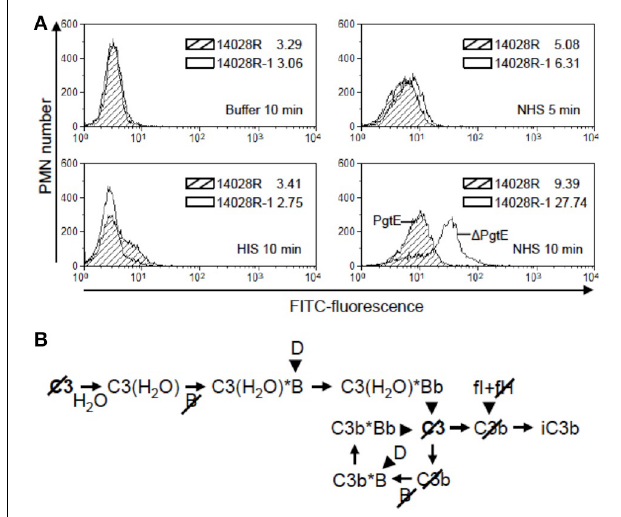
FIGURE 6 | The effect of PgtE on opsonophagocytosis of S. enterica . (A) FITC-stained S. enterica 14028R and 14028R-1 ( (cid:2) pgtE derivative of 14028R) were incubated for 5min in 50% NHS, 50% HIS or buffer. Freshly isolated human neutrophils were mixed with the bacteria at a MOI 20, and phagocytosis was allowed to take place for 5min (in NHS) or 10min (in NHS, HIS or buffer). The FITC signals from 10,000 paraformaldehyde-fixed neutrophils were measured using flow cytometry. Median values of fluorescence are shown. Striped area, 14028R; open area, 14028R-1. The experiment was conducted three times, each time with PMN from a different donor and with consistent results. A representative result is shown. (B) Progression of the alternative complement pathway up to the level of iC3b that is the main opsonic ligand for CR3 (CD11b/CD18) on neutrophils. Arrowheads indicate proteolytic cleavage. Slashes mark the components cleaved by PgtE.